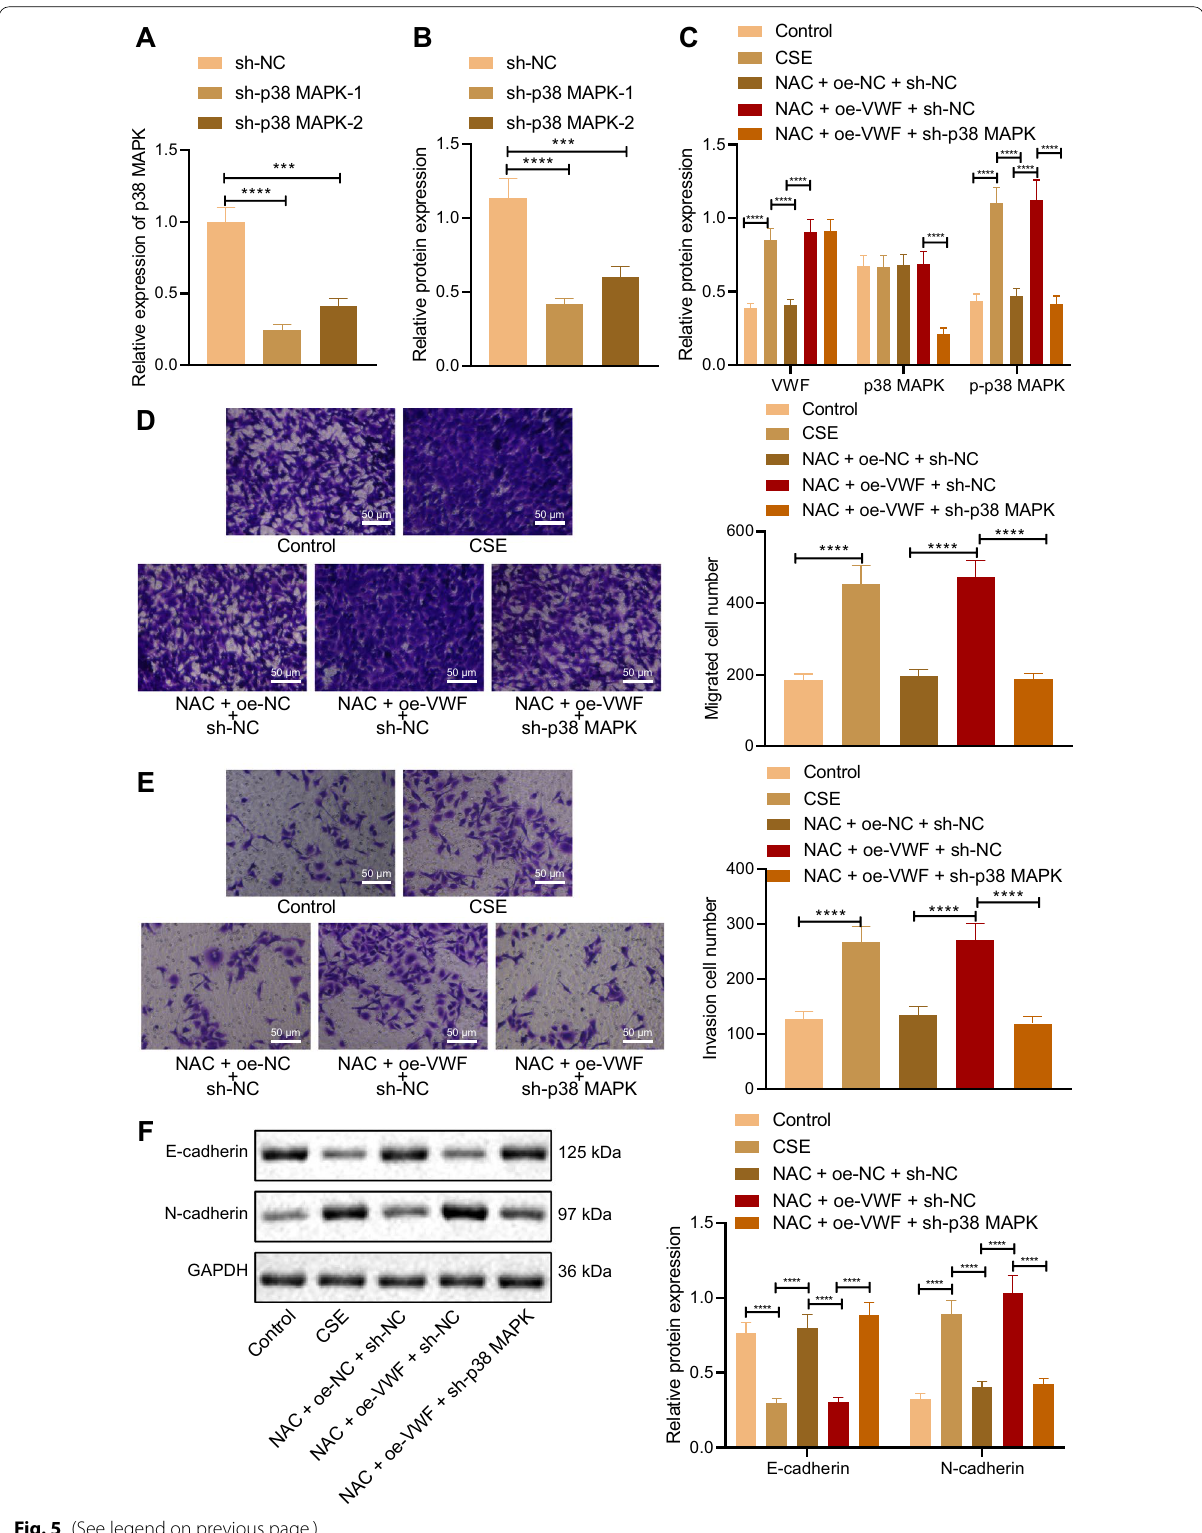
Fig. 5 (See legend on previous